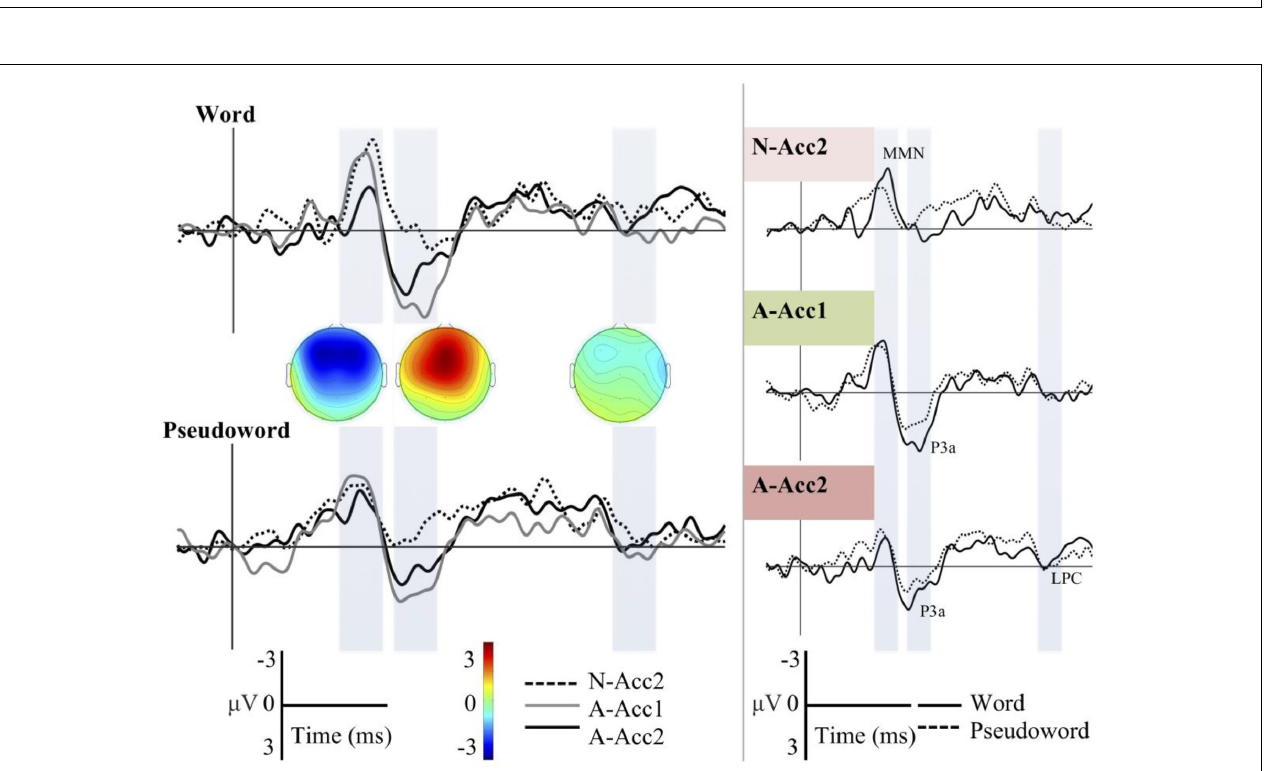
FIGURE 2 | Illustration of the grand average ERP waveforms. Amplitude is given in microvolts [ µ V, ( − 3, 3)] and time in milliseconds [ms, ( − 100, 900)]. Left Panel: Grand average difference waveforms for all the deviants across Word and Pseudoword blocks at the Fz channel. Dotted line: Neutral stimuli with Accent 2 (N-Acc2, i.e., change in linguistic prosody); Gray solid line: Angry stimuli with Accent 1 (A-Acc1, i.e., change in affective prosody); Black solid line: Angry stimuli with Accent 2 (A-Acc2, i.e., change in linguistic–affective prosody). Right Panel: Difference waveforms for both words and pseudowords separately for each deviant (color-coded in accordance with the Figure 1 ). Black solid line: Word block; Dotted line: Pseudoword block. Shaded bars: Time windows selected for statistical analysis (210–260, 300–350, and 570–620 ms, respectively).